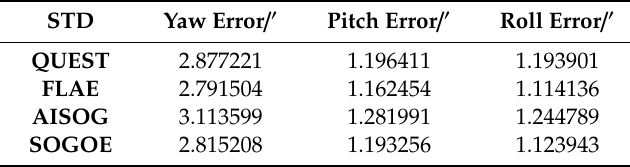
Table 7. Standard deviation of the steady-state